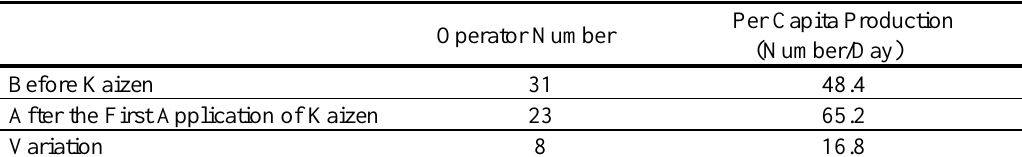
Table 1. Efficiency